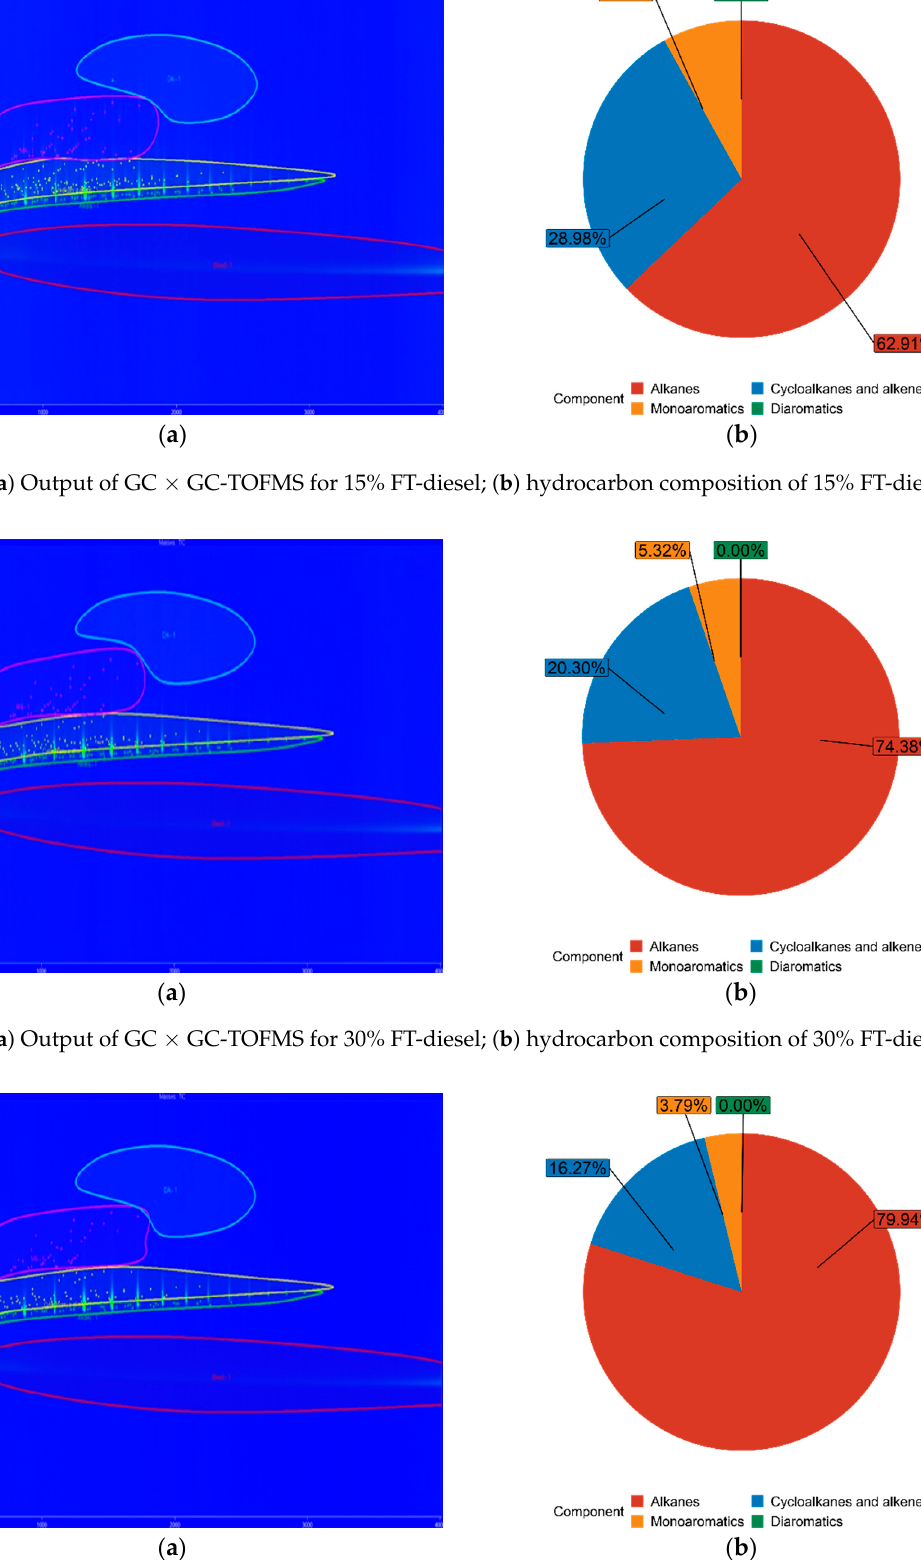
( b ) Figure 11. ( a ) Output of GC × GC-TOFMS for pure conventional diesel; ( b ) hydrocarbon composition of pure diesel.